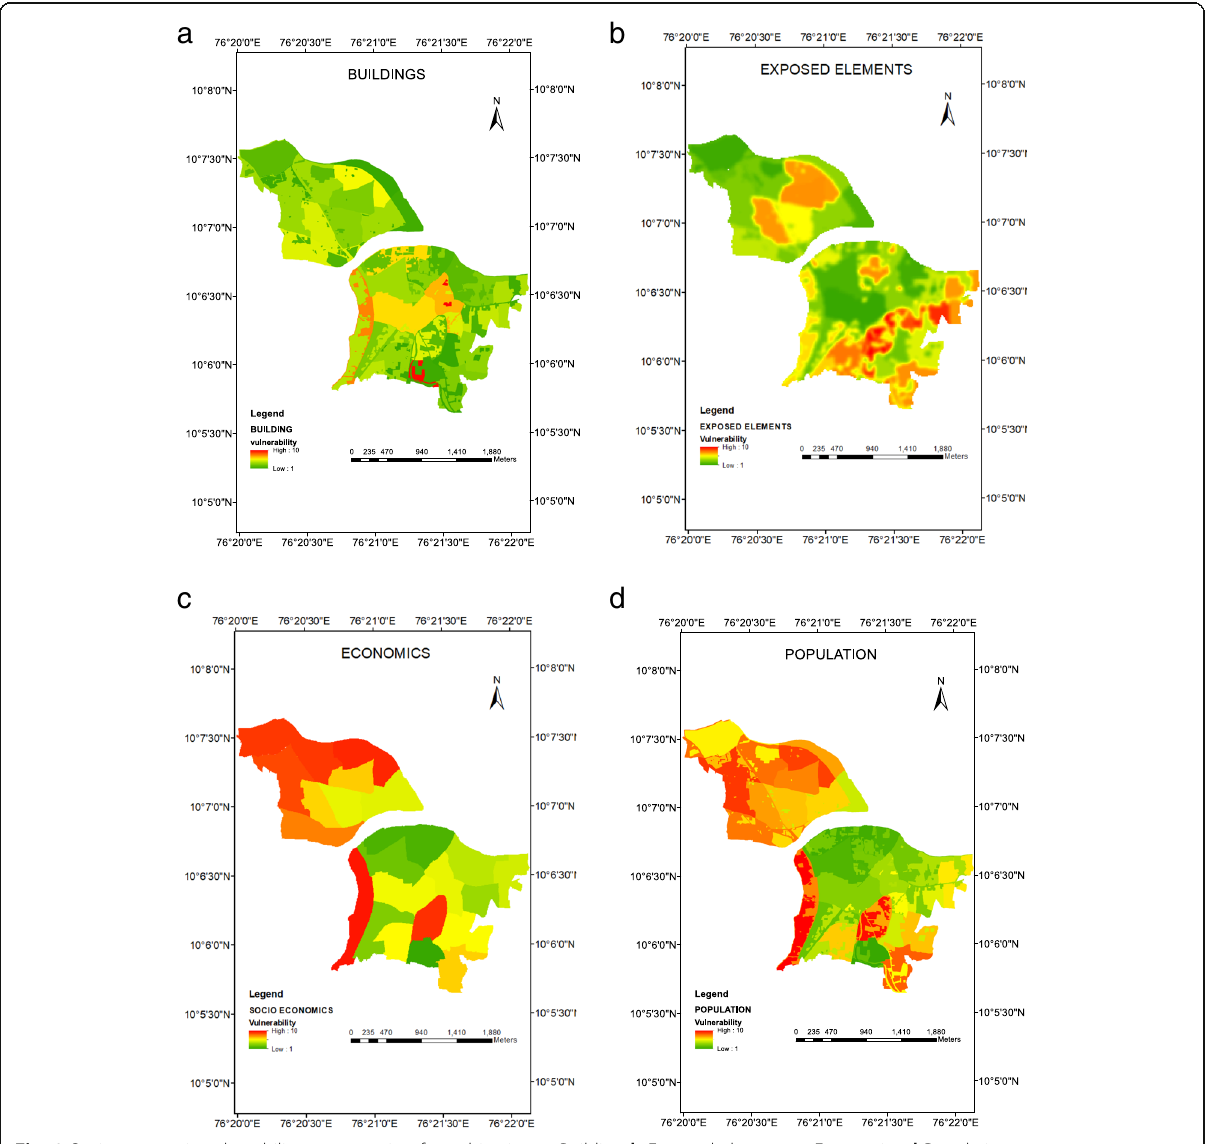
Fig. 8 Socio-economic vulnerability maps sowing four objectives a Building b Exposed elements c Economics d